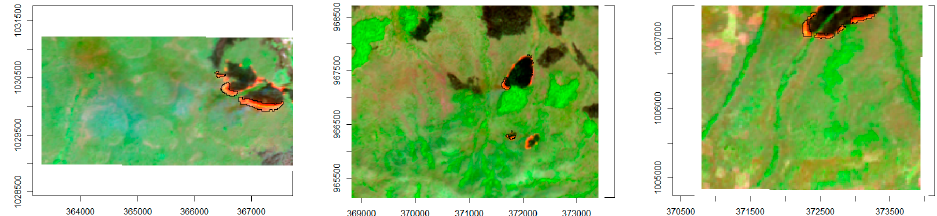
Figure 1. False color S ‐ 2 images of 20 (left) and 25 November 2020 (center and right panel) which were used as starting points for estimating ROS for the examples presented in Figure 2 ff. The detected S ‐ 2 fire fronts which were used for the ROS determination are marked with black outlines. Coordinates on the axes for all maps are UTM coordinates (in m) for UTM zone 30 N.